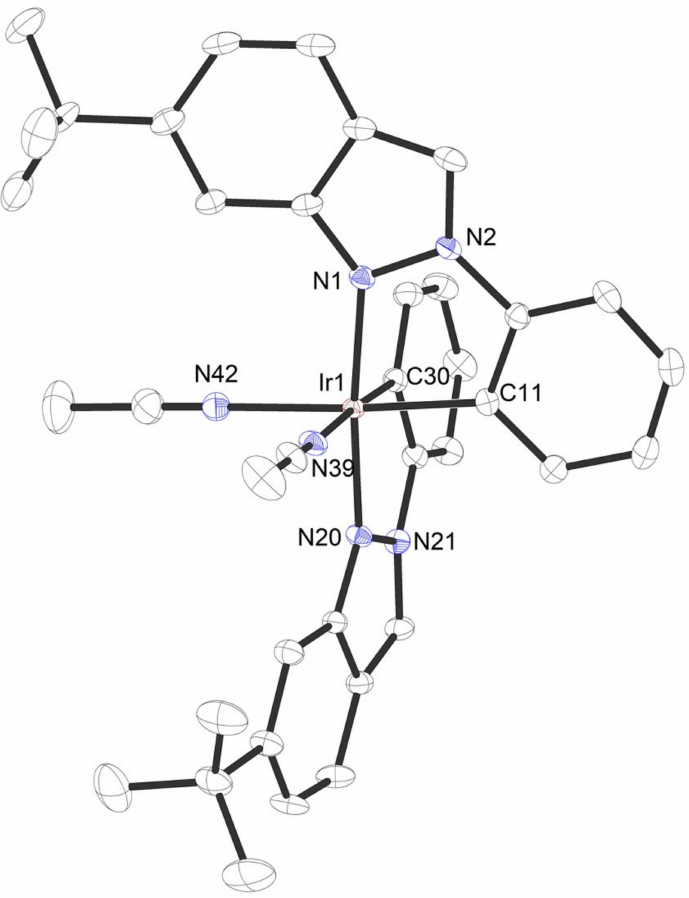
Figure 4. Crystal structure of Λ - IrInd . ORTEP drawing with 30% probability thermal ellipsoids. Hexafluorophosphate counterion and solvent molecules are omitted for clarity. Table 1. Catalytic enantioselective conjugate addition of indole to 2-acyl imidazole 4 a .